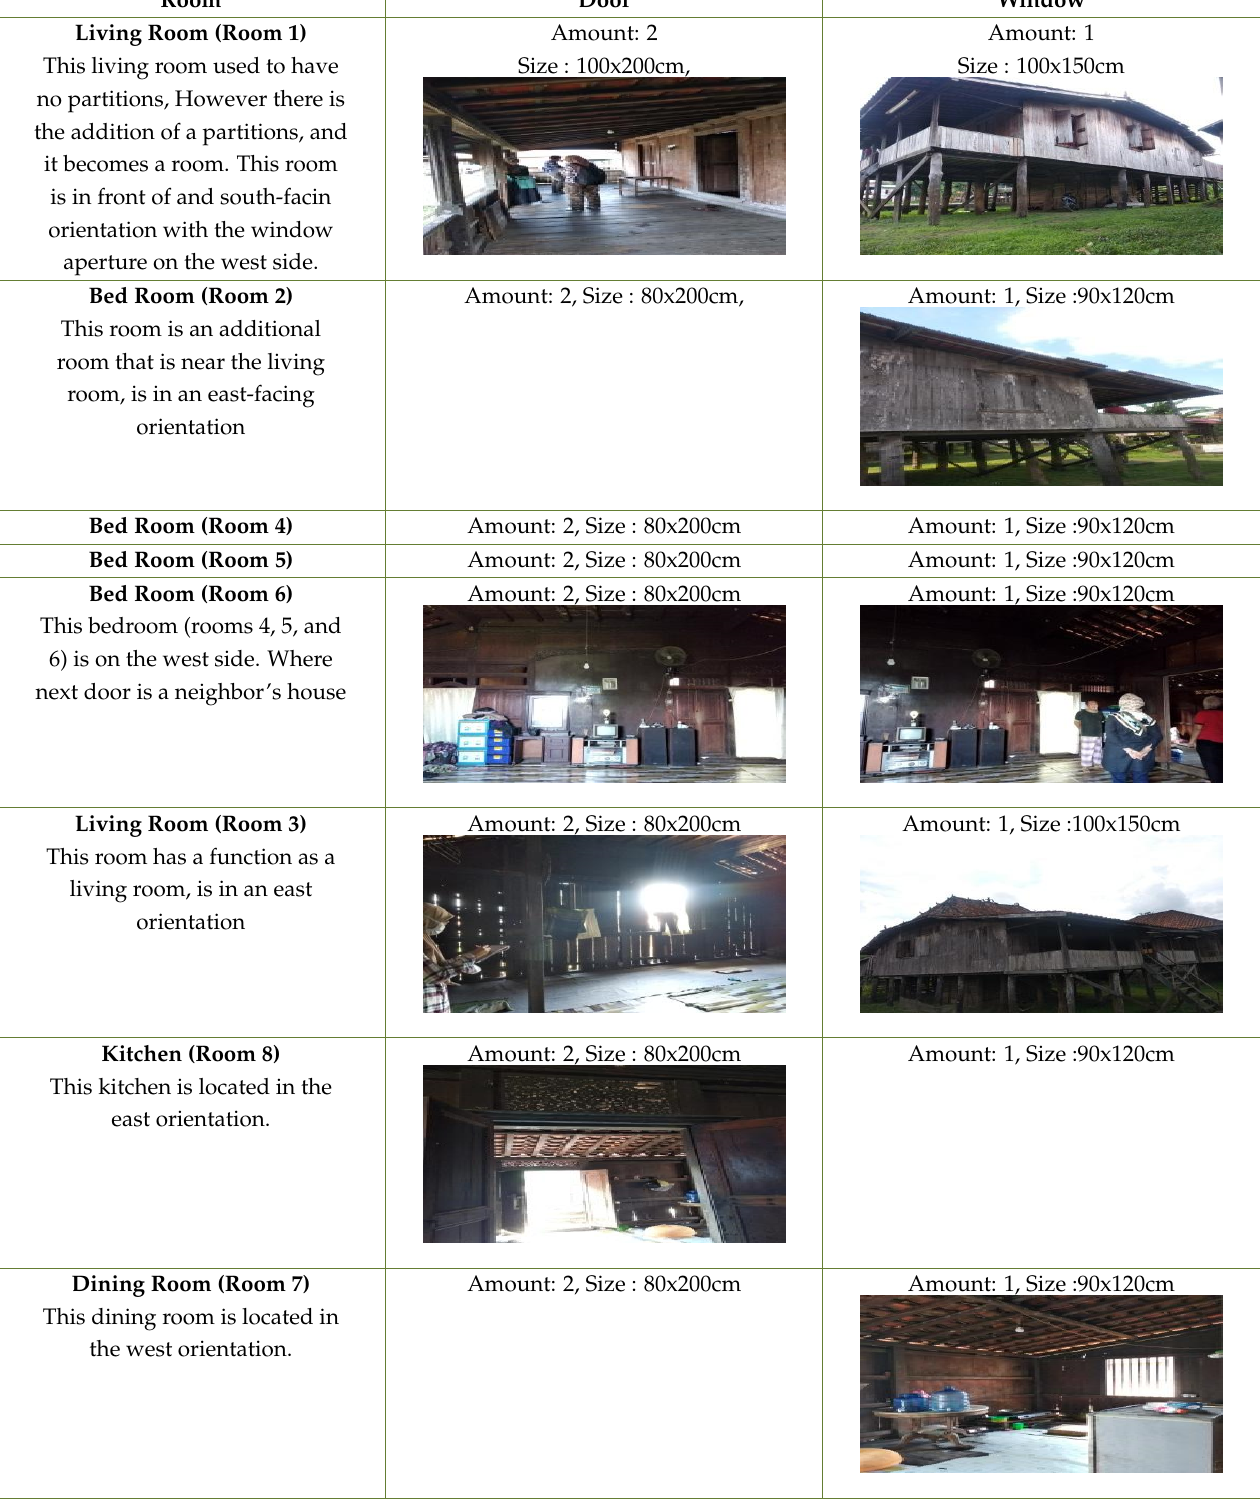
Table 1. Application of Door and Window Aperture on Building Sheath